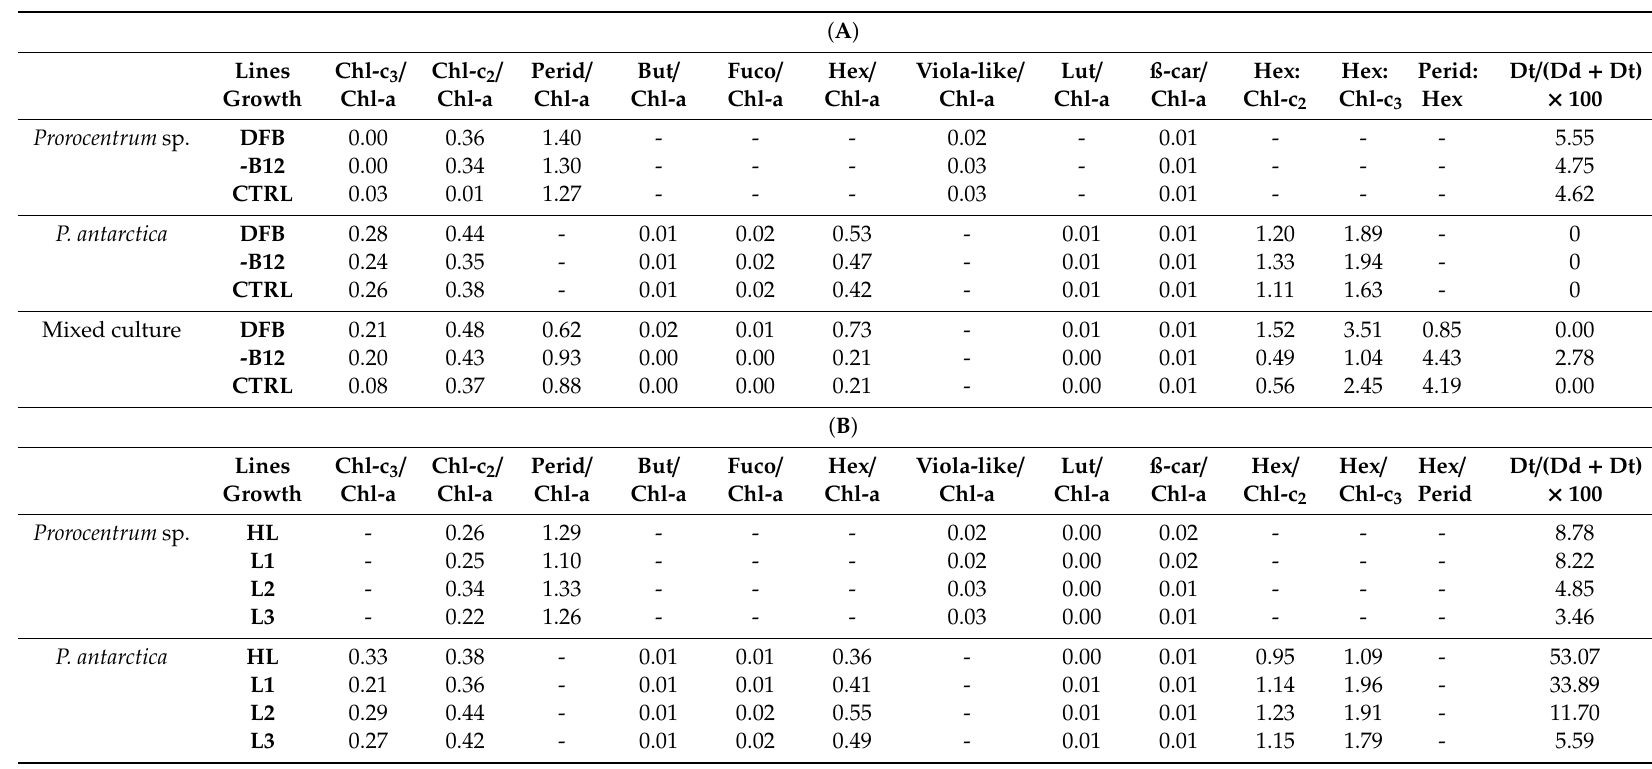
Table 1. Pigment:Chl-a ratios. ( A ) In Prorocentrum sp., Phaeocystis antarctica , and the mixed culture under di ff erent treatments in Experiment 1; ( B ) In Prorocentrum sp. and Phaeocystis antarctica under di ff erent light irradiances in Experiment 2. Abbreviations: Chl-a, chlorophyll-a; Chl-c 3 , chlorophyll-c 3 ; Chl-c 2 , chlorophyll-c 2 ; Perid, peridinin; But, 19 (cid:48) -butanoyloxyfucoxanthin; Fuco, fucoxanthin; Hex, 19 (cid:48) -hexanoyloxyfucoxanthin; Viola-like, violaxanthin-like pigment; Lut, lutein).